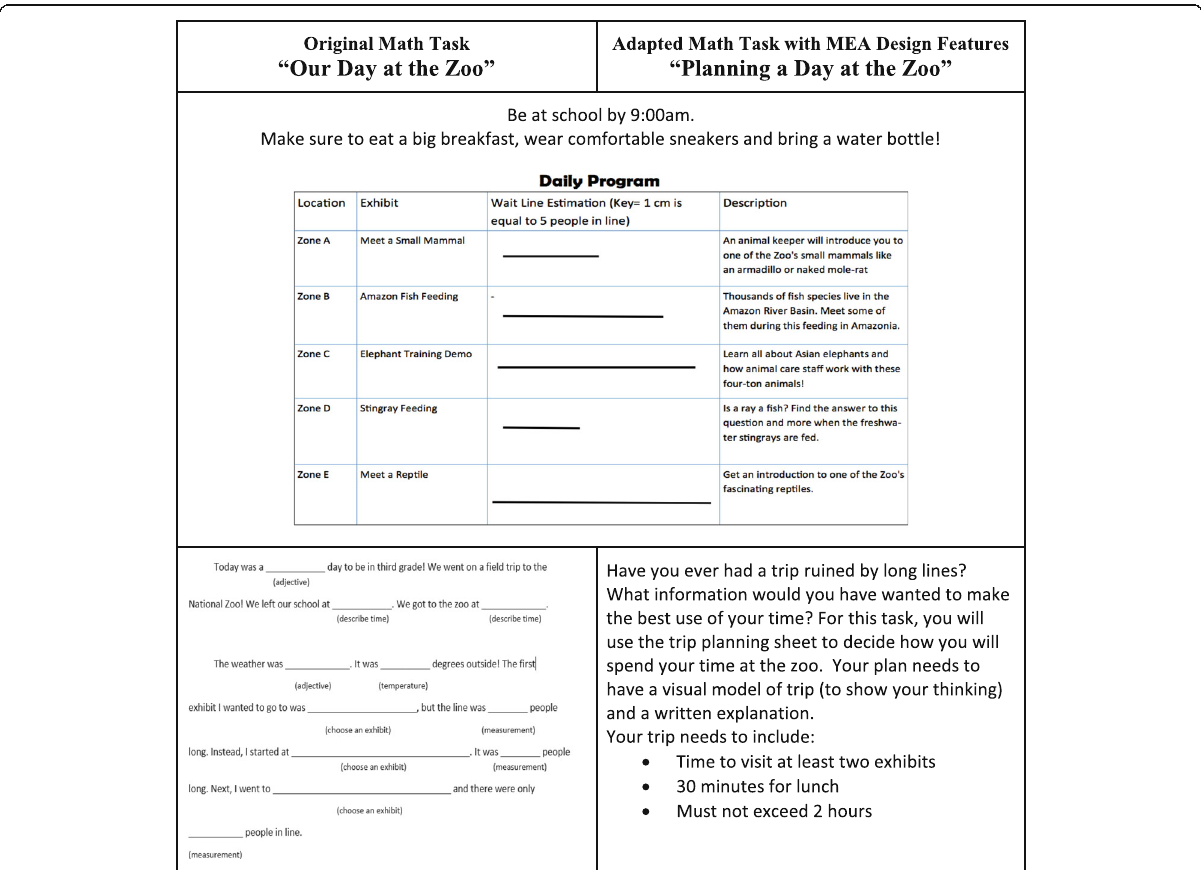
Fig. 5 Adaptations for 3rd grade “ A Day at the Zoo ”